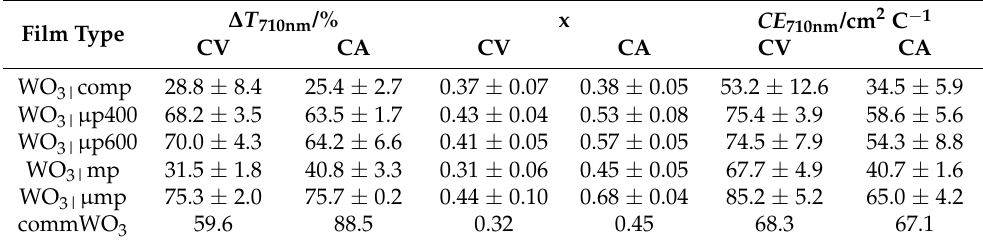
Table 8. Mean values and standard deviation of the transmittance modulation ∆ T 710nm , the Li + content x in Li x WO 3 and the coloration efficiency CE 710nm obtained from CV at a scan rate of 5 mV s − 1 or from CA